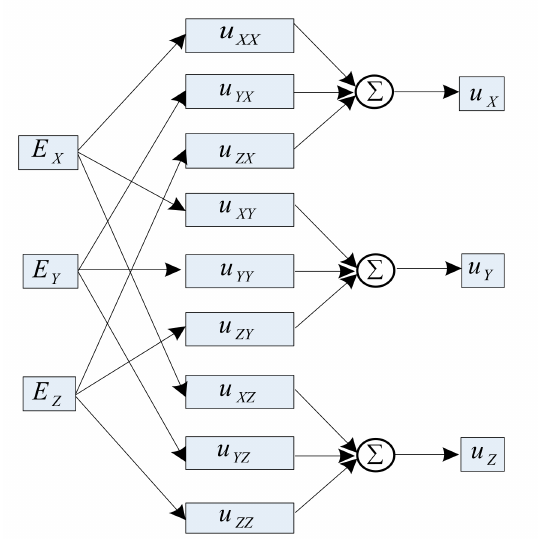
Figure 3. Input and output model of three dimensional electric field